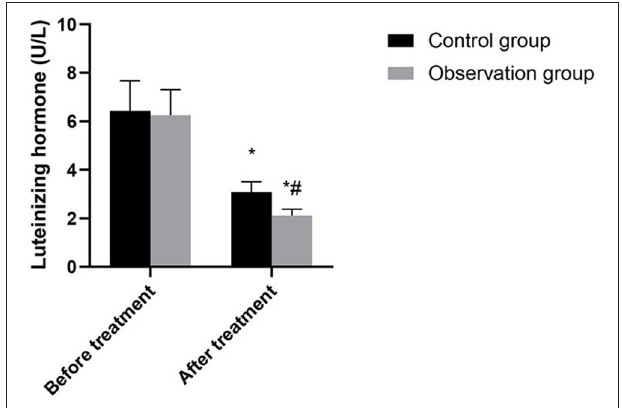
FIGURE 1 | Comparison of luteinizing hormone between the two groups. Compared with before treatment, * P < 0.05. Compared with control group, # P < 0.05.